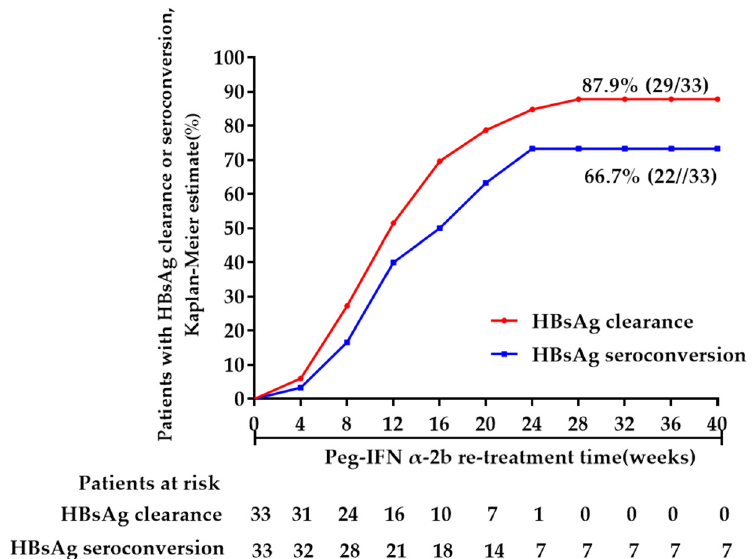
Figure 2. HBsAg clearance and seroconversion during peg-IFN α -2b re-treatment (Week 0 was defined as the time when the patients were enrolled in this study). Table 2. Detailed therapeutic and follow-up information for the 33 patients enrolled in this study.